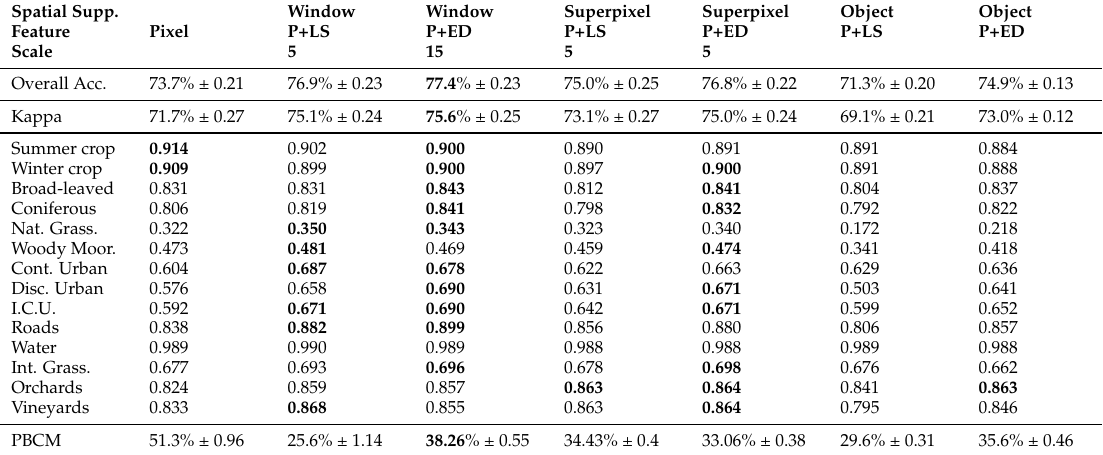
Table 4. Overall and per-class accuracy (F-score), for the best feature/support combinations on the tile T31TCJ. In the feature descriptions, P indicates the presence of pixel information, while LS stands for local statistics, and ED for edge density. The bold numbers indicate the two highest values for each metric. The PBCM of these cases is also shown. The combination of sliding window, pixel and edge density provides the best results over most of the urban classes. Superpixels with pixel and edge density features provide similar values in overall accuracy, but their geometric precision seems to be